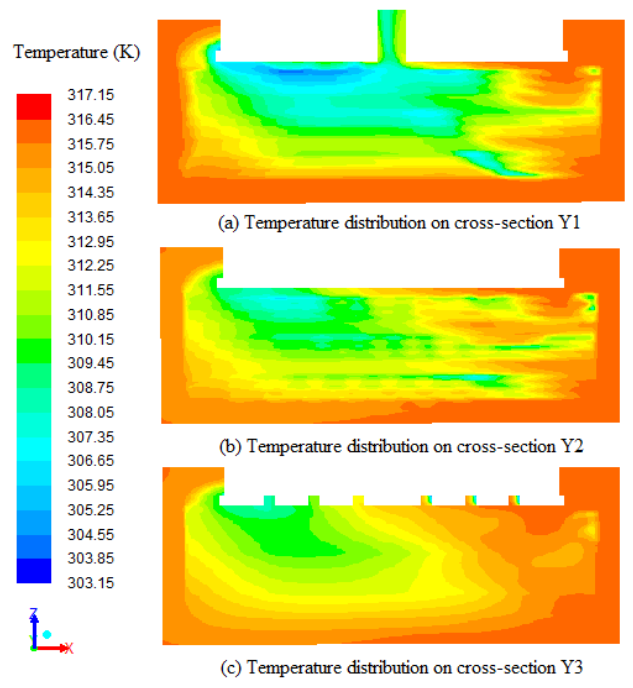
Figure 9. Temperature distributions comparing three different cross-sections (Y1, Y2 and Y3) of the tobacco curing chamber at 108,000 s.